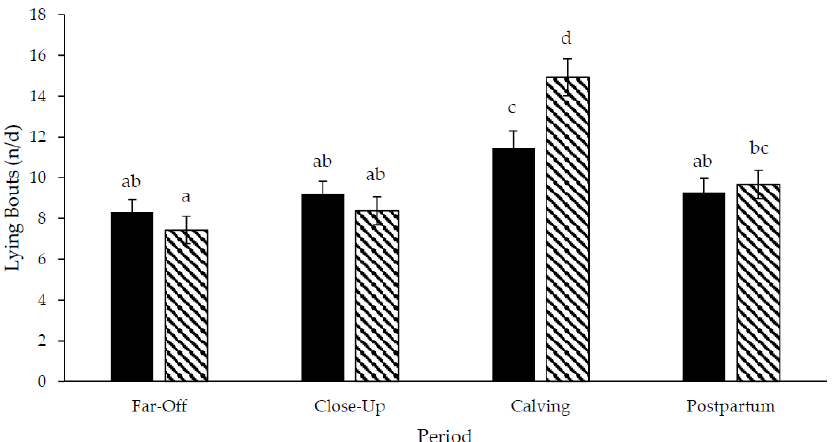
Figure 4. Lying bouts of Holstein cows managed in freestalls (solid bars; n = 14) or on pasture (striped bars; n = 14) during the dry period and early postpartum. Far-off: 60 to 15 d prepartum; close-up: 14